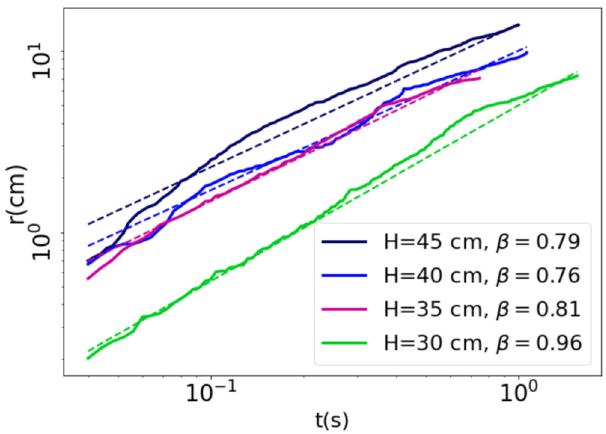
Fig. 7. Example of density of bubbles in function of the distance to the jet compared with the global model from equation (9).